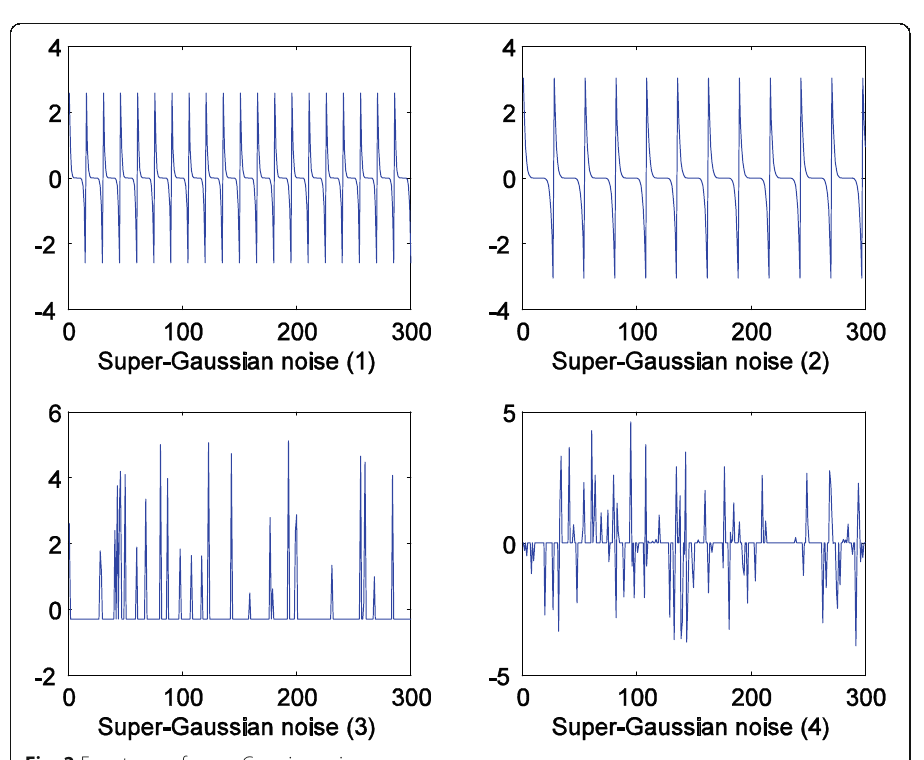
Fig. 2 Four types of super-Gaussian